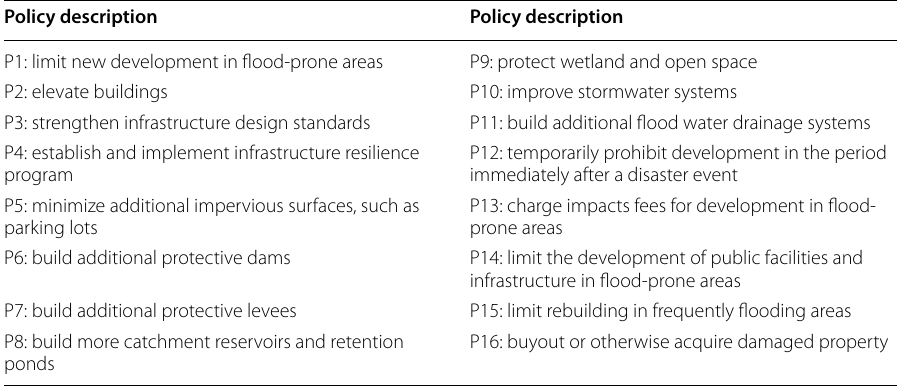
Table 1 Flood risk reduction policy actions in the survey Policy description Policy